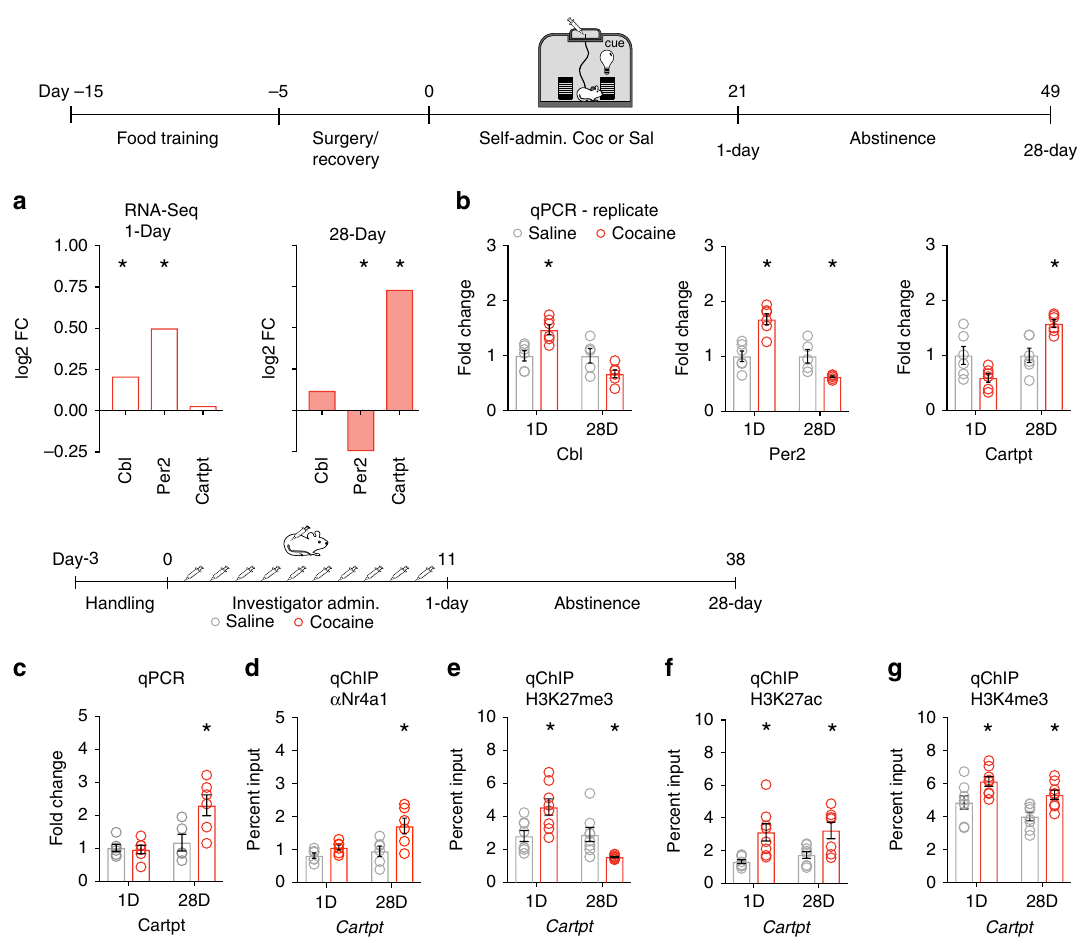
Fig. 2 Cocaine regulated Nr4a1 target genes and promoter function. a RNA-seq measures activation of Cbl and Per2 following cocaine SA at 1-day of abstinence and Cartpt activation and Per2 repression at 28-days, log2 fold change normalized to saline controls, q -value < 0.001. b qPCR following cocaine SA, in a biological replicate, identi fi es activation of Cbl ( n = 5 – 6 mice/group, two-way ANOVA, followed by Tukey ’ s multiple comparisons test, 1-day P = 0.0099) and Per2 ( n = 5 – 6 mice/group, two-way ANOVA, followed by Tukey ’ s multiple comparisons test, 1-day P = 0.0002) at 1-day of abstinence,